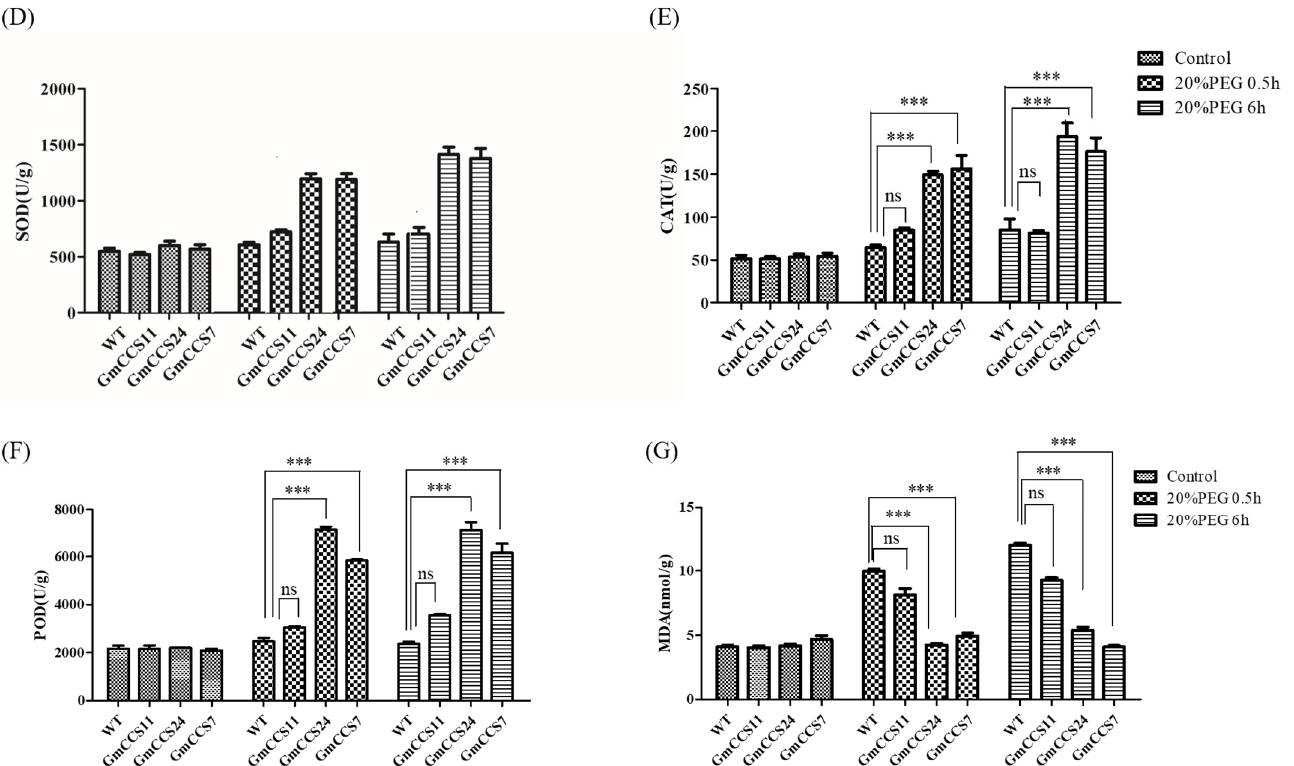
Figure 9. Soybean hairy roots expressing GmCCS7 / GmCCS24 showed improved drought stress tolerance. ( A ) RT-qPCR analysis of GmCCS7 , GmCCS11 and GmCCS24 transcript levels in transgenic hairy roots. Transcript levels relative to TUA5 were represented in each treatment; error bars indicate standard deviation (n = 3 plants). ( B , C ) Performance and survival rates of soybean seeding plants with transgenic hairy roots overexpressing GmCCS7 / GmCCS11 / GmCCS24 under drought stress; error bars indicate standard deviation (n = 15 plants). ( D – G ) The antioxidant enzymes (POD, SOD and CAT) and the MDA content analysis under drought stress; error bars indicate standard deviation (n = 10 plants). The ns indicate none significant. One-tailed student’s t -test was used to generate the p values. Stars indicate significant difference (*** p < 0.001) compared to control plants (expressing empty vector).